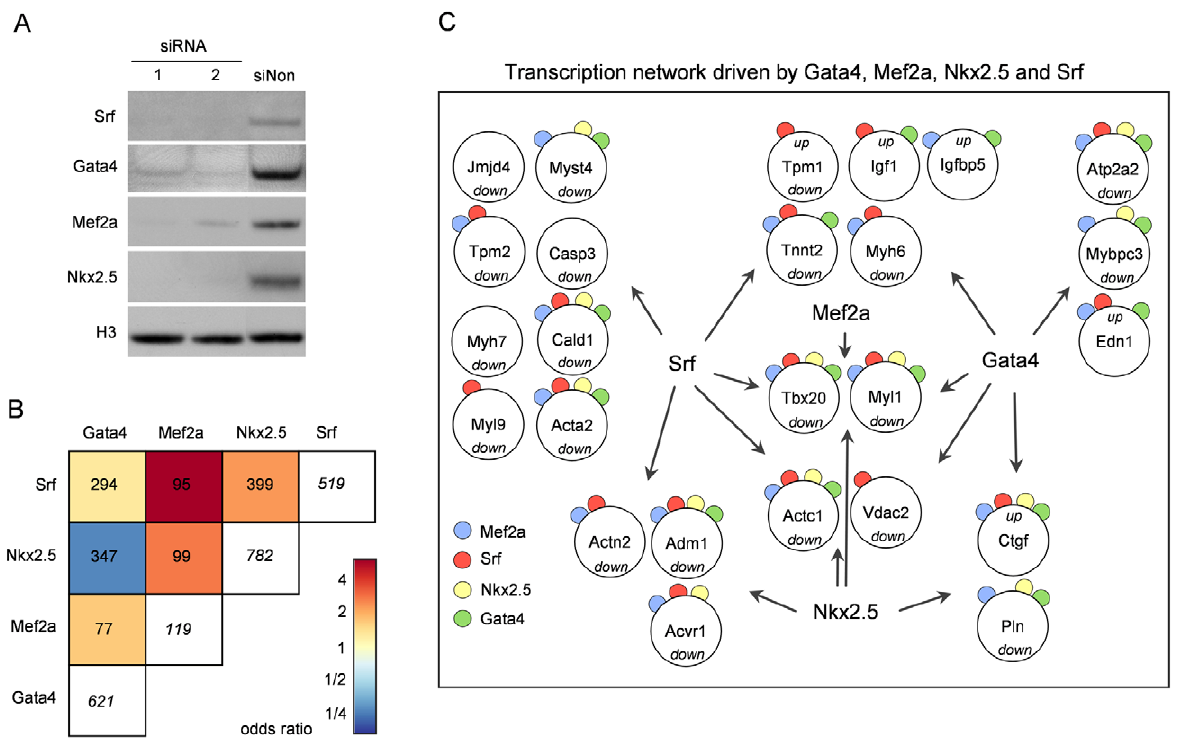
Figure 2. RNAi–induced knockdown of Gata4, Mef2a, Nkx2.5, and Srf. (A) Knockdown efficiency of Gata4, Mef2a, Nkx2.5 and Srf in HL-1 cells using two different siRNAs was analyzed on protein level by Western Blot 48h after transfection. Histone 3 (H3) served as loading control. In independent experiments similar knockdown efficiencies were obtained. (B) Odds ratios of pair-wise contingency tables of differentially expressed transcripts after RNAi knockdown of the respective transcription factor. Total numbers of pair-wise occurrences are given. The numbers in white boxes represent the total number of deregulated transcripts. Red indicates positive, blue negative correlation. Mef2a shows the lowest number of differentially expressed transcripts (119) probably due to buffering effects of the other Mef2 family members. Despite this fact, Mef2a shares a high number of deregulated transcripts with the other transcription factors. Of note, transcription factors having a high number of common binding targets (see Figure 1D) share only a small number of co-regulated genes in RNAi knockdown. (C) Transcription factor network showing a selection of cardiac relevant genes bound in ChIP-chip and/or ChIP-seq, and significantly differentially expressed in RNAi knockdown experiments of the respective factor. Up- and downregulation of genes is depicted and occurrence of ChIP binding marked by color-coded circles.